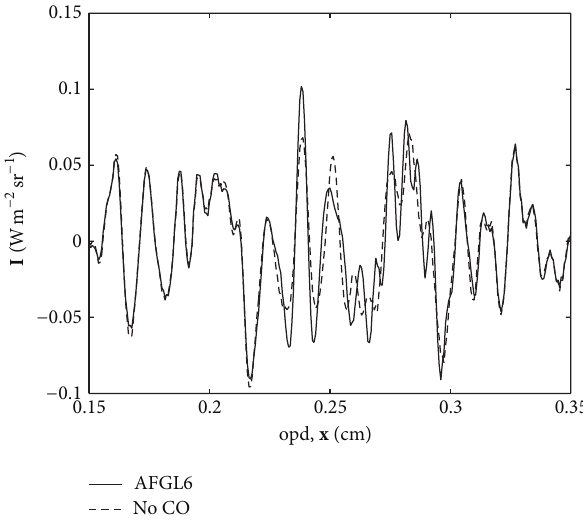
Figure2:Interferogramradiance( I )aroundtheexpectedresonance peak of CO in Wm −2 sr −1 . The optical path difference (opd) is expressed in cm. AFGL6 stands for the US standard atmosphere, while “no CO” refers to the same atmospheric profile with a null CO